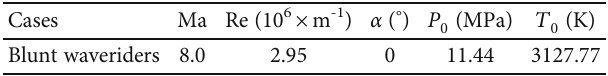
Figure 9: Comparisons between numerical results and experimental data: (a) C Table 3: Computational conditions for the blunt waveriders.